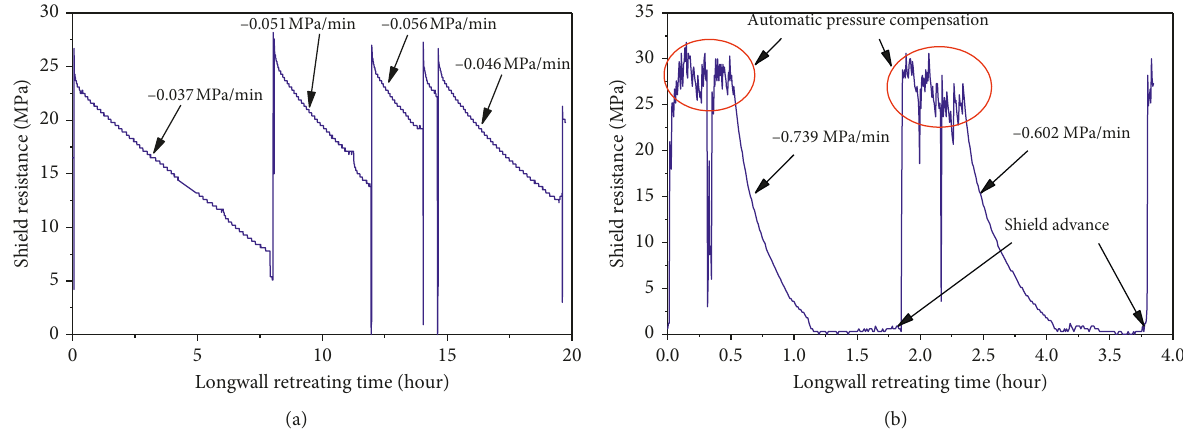
Figure 18: Change of shield resistance with longwall retreating time during minor leakage (a) and rapid leakage